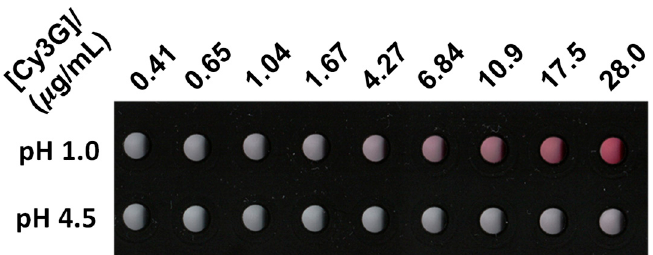
Figure 4. A scanned photo of the PDMS chip where the colorimetric reaction occurred in the set of